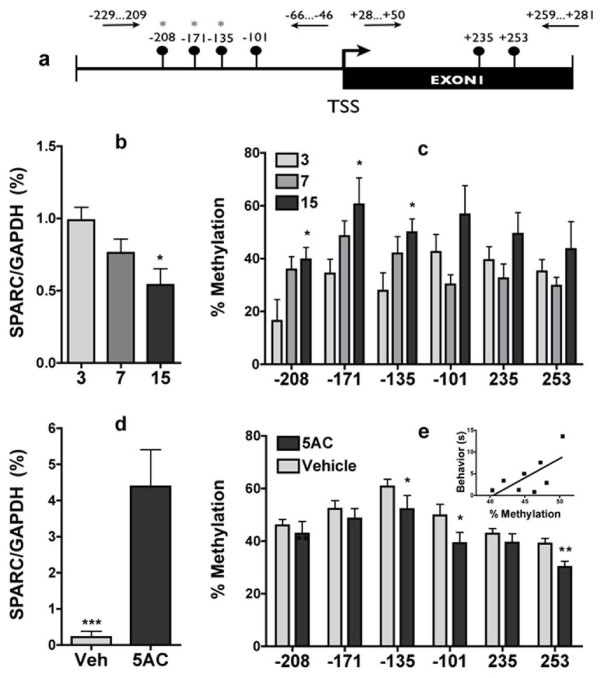
Changes in expression and DNA methylation of SPARC in aging mice. SPARC mRNA expression (relative to gapdh) at different time points in life (b). Age-dependent changes in methylation of CG sites in the SPARC promoter (a) in IVDs as quantified by pyrosequencing (c). Treatment of 1-year old mice with the demethylating drug 5AC or vehicle (30 mg/kg, i.v. and 250 fmol i.t.) resulted in a 4-fold increase in SPARC mRNA expression and (d) decreased methylation of CG sites in the SPARC promoter as quantified by pyrosequencing in IVDs. Inset: Increased cold sensitivity following 5AC injection was significantly correlated with total SPARC methylation. * = p < 0.05, *** = p < 0.001. One-way ANOVA followed by Bonferroni's test (aging cohorts) and two-tailed student t-test (5AC vs. vehicle treated). Pearson's correlation (p = 0.03, r2 = 0.46). n = 3-15/group. Error bars = S.E.M.